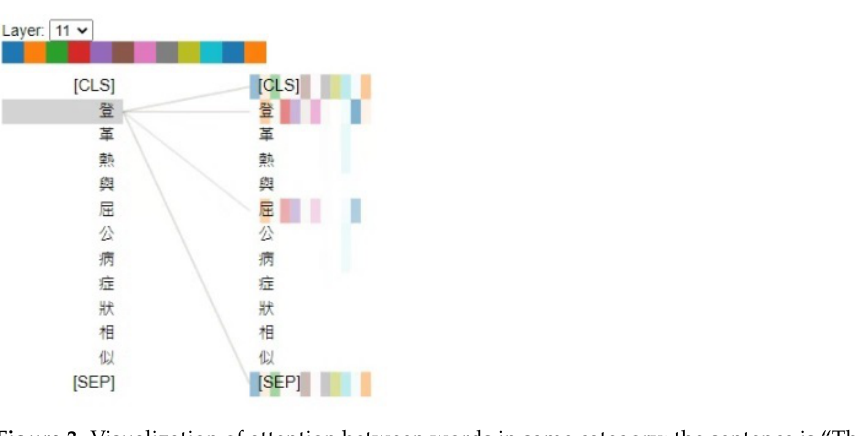
Figure 3. Visualization of attention between words in same category; the sentence is “The symptoms of dengue fever and chikungunya are similar.”